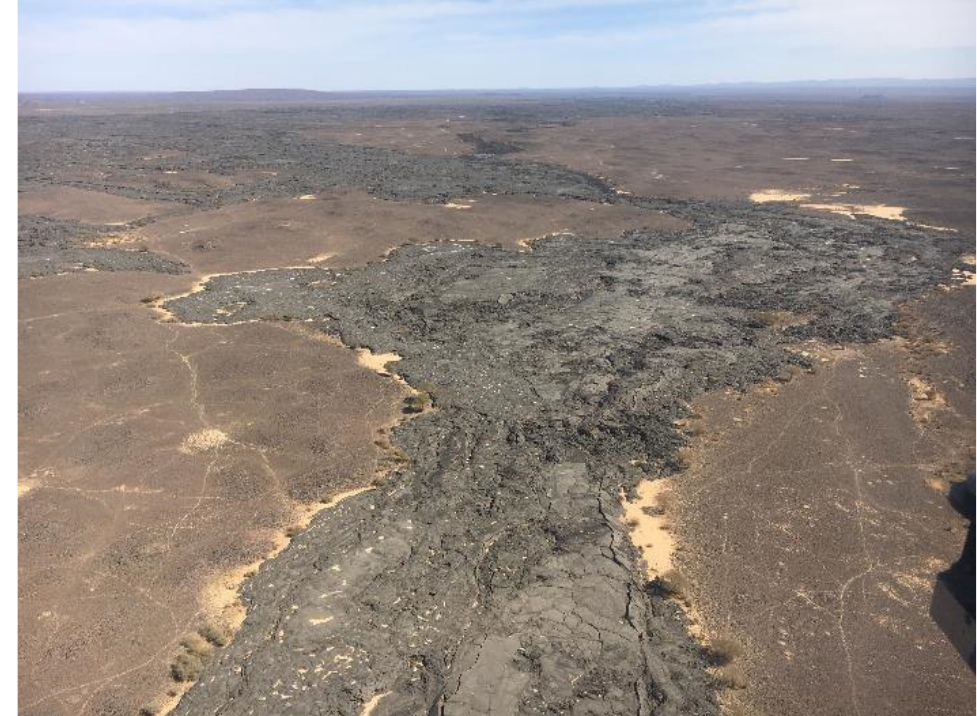
Figure 14. Tube-fed hummocky surfaced lava flow arm that is emplaced in a very shallow wadi about 45 km away from its source from the fissure vents north of Jabal Quidr. Photo was taken from a helicopter looking upflow toward the NE. Note the very flat, but gentle, sloping topography across which the lava flow spreads. The narrow neck of the lava flows in the foreground is about 75 m wide, and its location is 25°39 13 N 39°30 18 E.